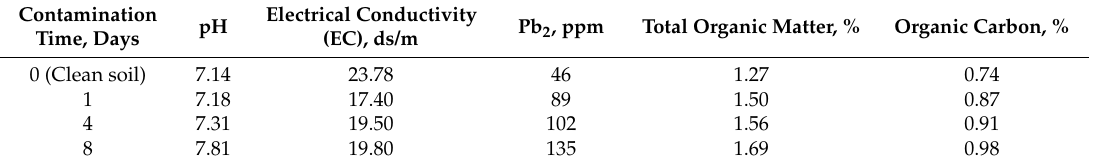
Table 4. Chemical characteristics of clean and crude oil contaminated soil after 1, 4, and 8 days of